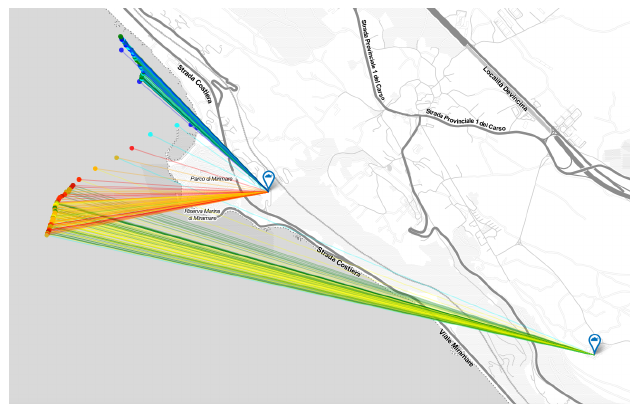
Figure 5. Links established by the drifter to the gateways at ICTP (upper) and Monte Grisa (lower)